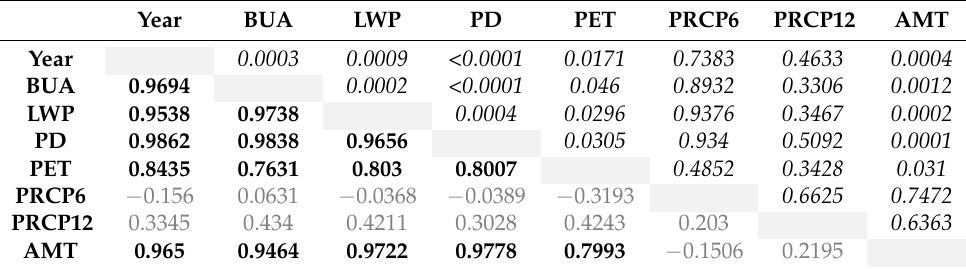
Table 2. Correlation coefficients (lower half of matrix) and p -values (upper half of matrix) between possible drivers of waterbody change. Bolded correlation coefficients are significant at p ≤